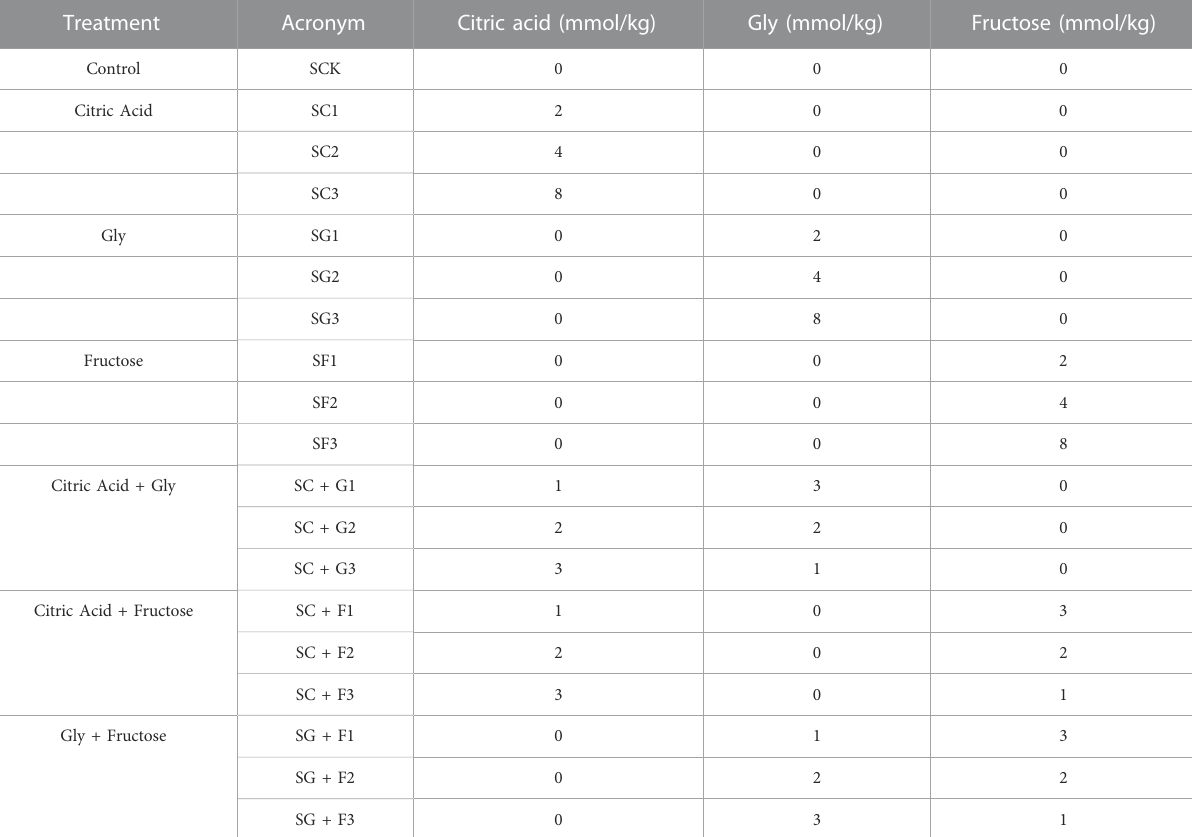
TABLE 1 Experimental design of single and in combination addition of citric acid, Gly and fructose at different concentrations.